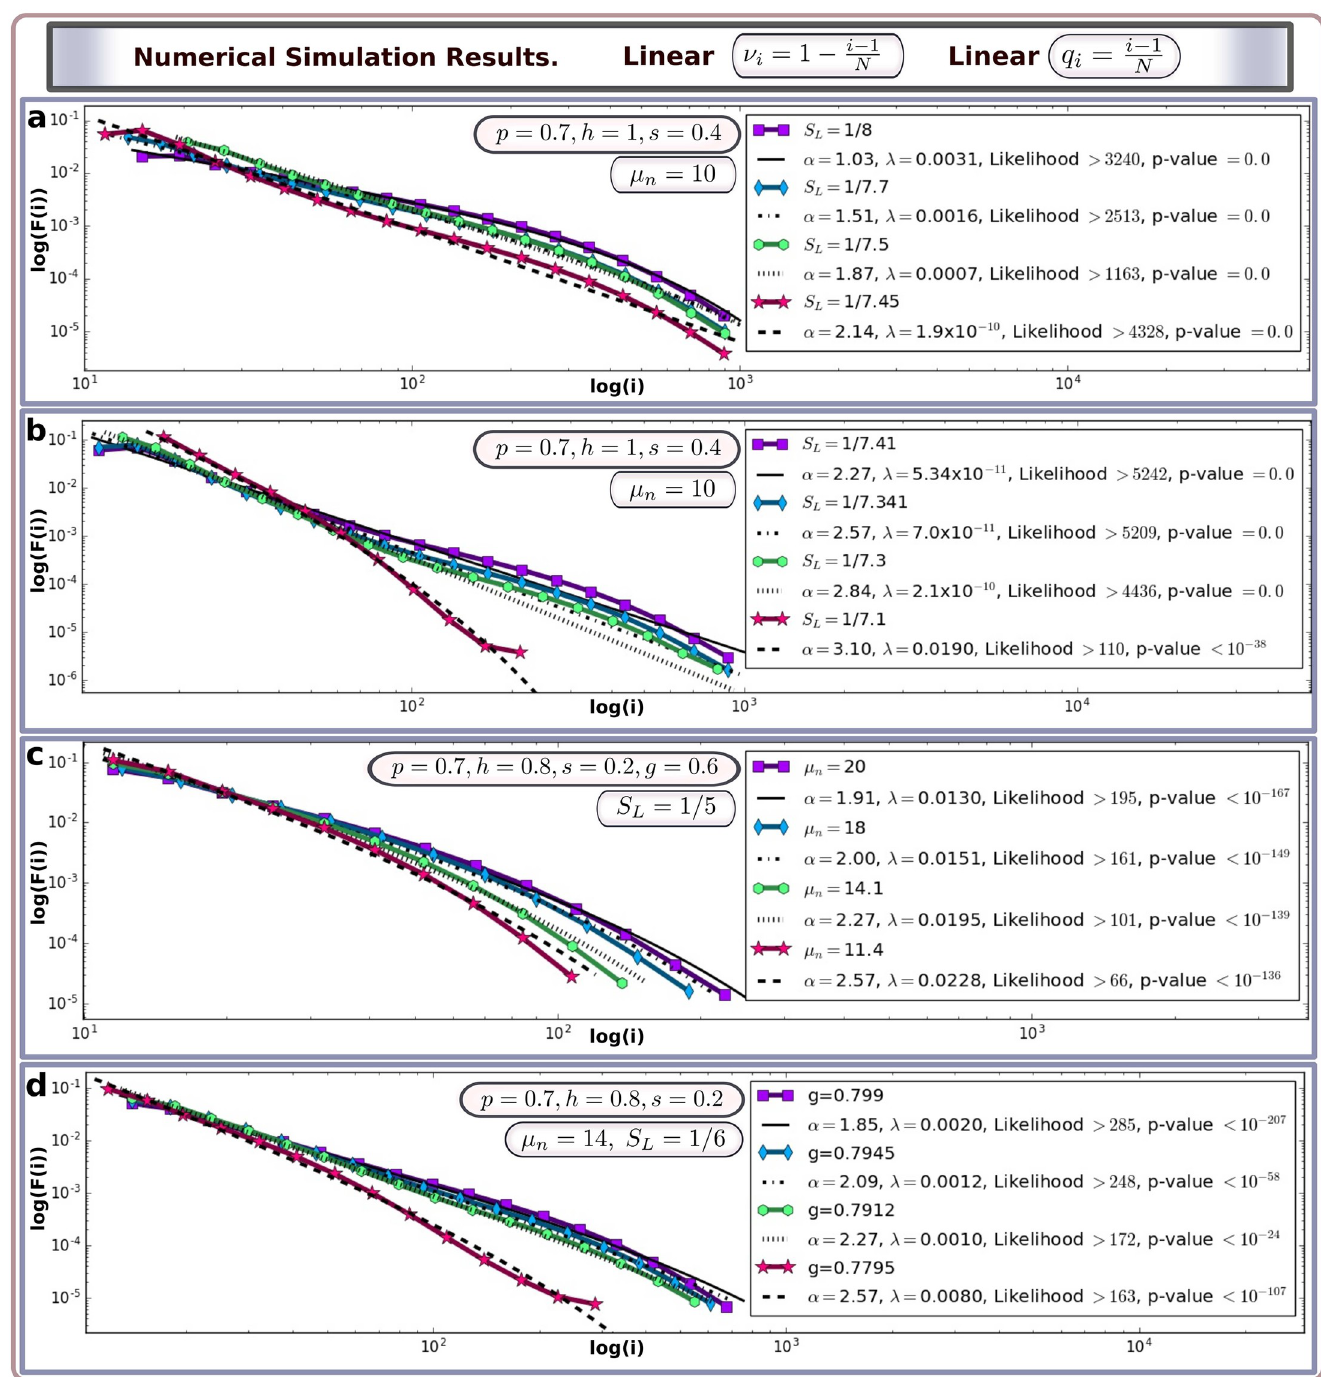
Fig 4. Statistical distribution of spacers in CRISPR array predicted by the mathematical model with linear parameterisations of q lines with dots represent the final distribution F � in the model. The thin, dashed, dotted, and dash-dotted lines show the fitting of the power law distribution with exponential cutoff given by p ( i ) * i − α e − λ i . In the labels, likelyhood stands for Loglikelyhood ratio of truncated power law distribution to the second best fit. ( a,b ) For the fixed parameter values p = 0.7, h = 1, s = 0.4 and μ = 10, increasing the fraction of spacers lost during replication from S n law exponent from α from 1.03 to 3.1. ( c ) For the fixed parameter values p = 0.7, h = 0.8, s = 0.2, g = 0.6 and μ n = 10, decreasing the average number of spacers gained due to viral infection μ from 20 to 11.4 increases the power law exponent from 1.91 to 2.57. ( d ) For the fixed parameter values p = 0.7, h = 0.8, s = 0.2, S n = 14, decreasing the probability of survival in the case of a mutated protospacer from 0.799 to 0.7795 increases α from 1.85 to 2.57. In all of the above cases we assume that 100 μ = μ = μ . Decreasing the value of μ has a similar effect as decreasing μ (see Fig F in S1 Text). k m n m n